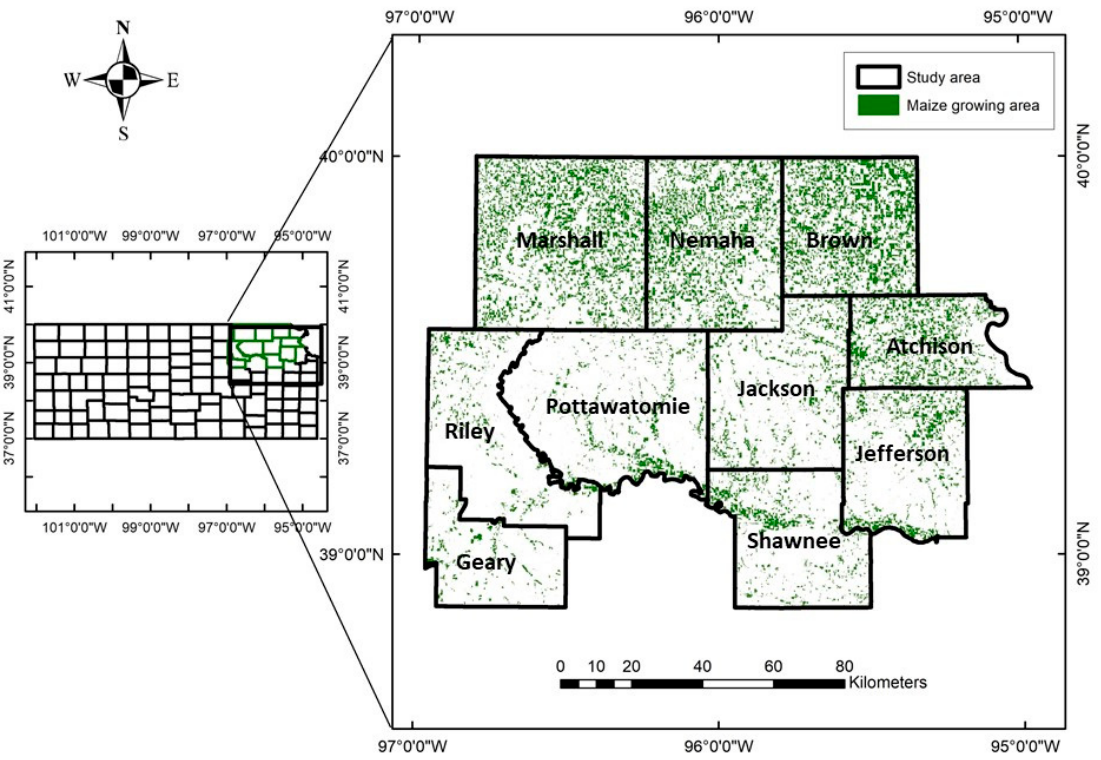
Figure 1. Study area map consisting of ten rainfed maize-producing counties in northeastern Kan- sas.